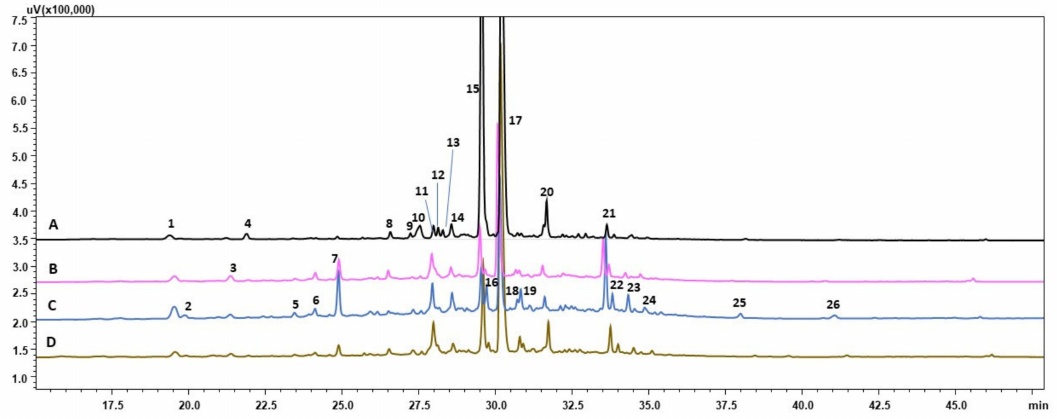
Figure 2. HPLC-PDA chromatograms (wavelength 320 nm) of RgAR line root extracts: (A) 28-day-old (time zero); (B) 14-day old untreated roots-control; (C) roots treated 14 days with drought stress; (D) roots treated 14 days with cold stress.